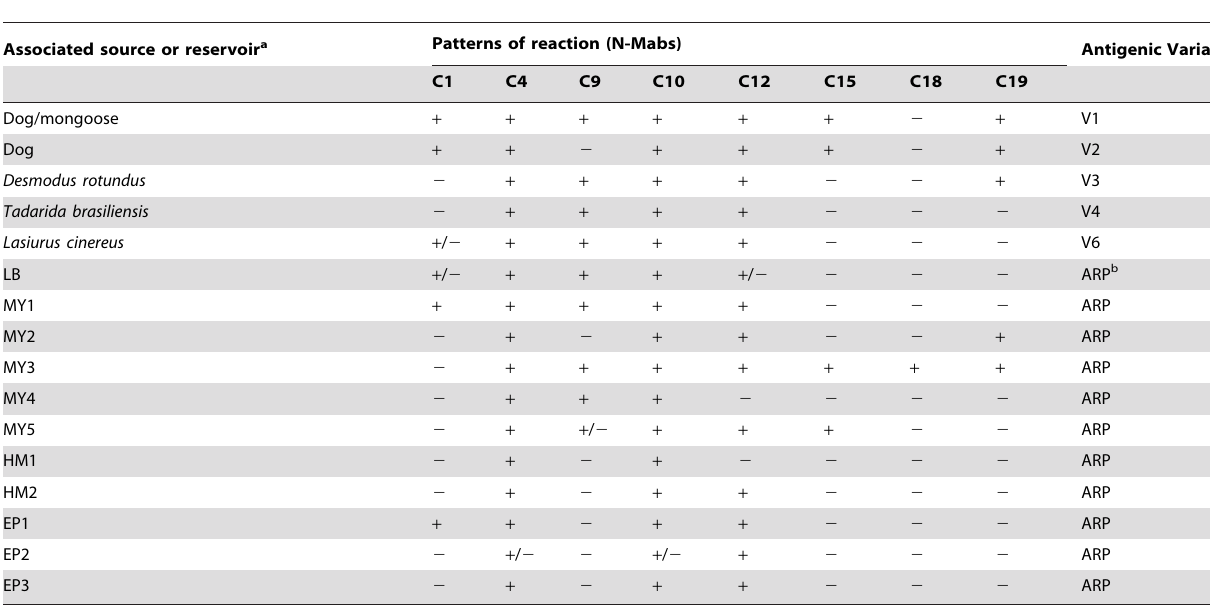
Table 2. Antigenic patterns of bat rabies viruses from Argentina.